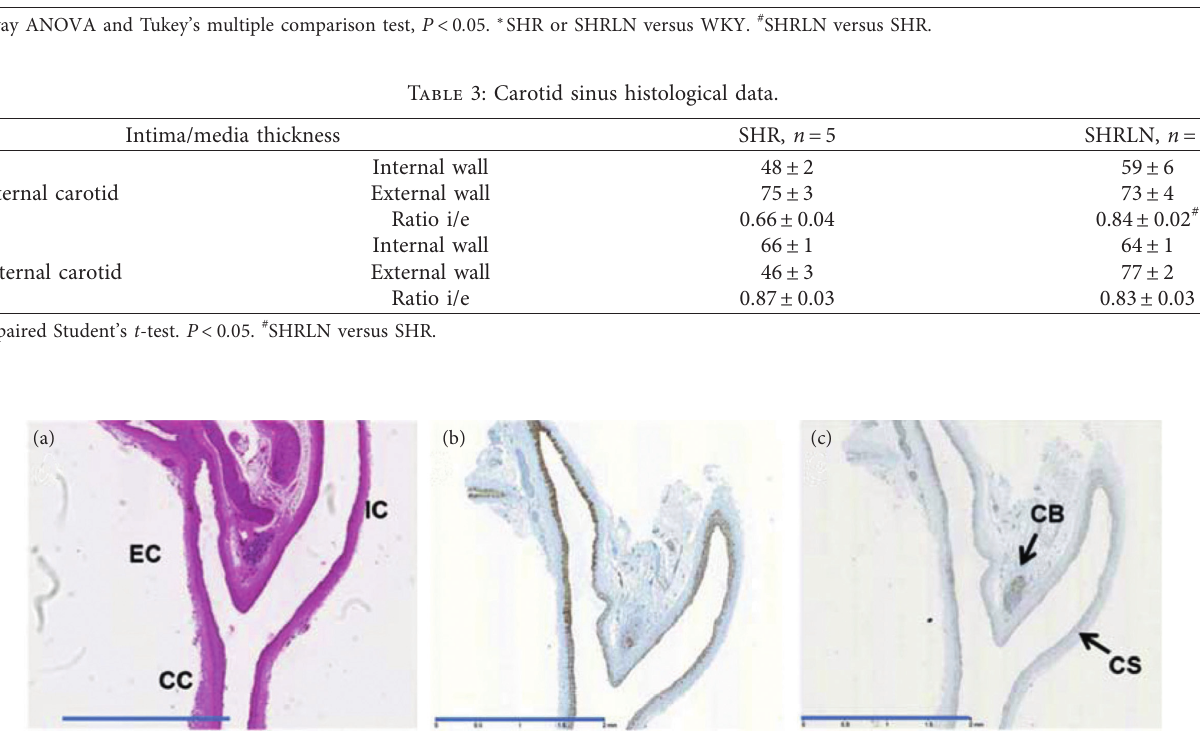
Figure 3: Carotid sinus histology. (a) Hemalum-eosin staining, (b) smooth muscle actin, and (c) chromogranin A. Blue scale bar is 2mm. There is no difference between SHR and SHRLN. CC, common carotid; EC, external carotid; IC, internal carotid; CB, carotid body; CD, carotid sinus. The examples shown are SHR sections, and no difference was visible on SHRLN sections.